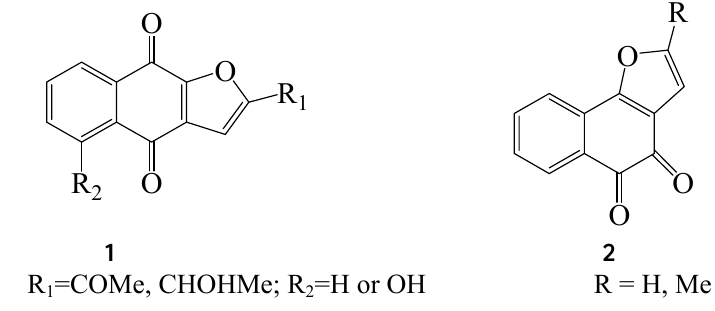
Figure 1. Structures of naphtha[2,3- b ]furan-4,9-diones 1 and naphtha[1,2- b ]furan-4,5-diones 2 .